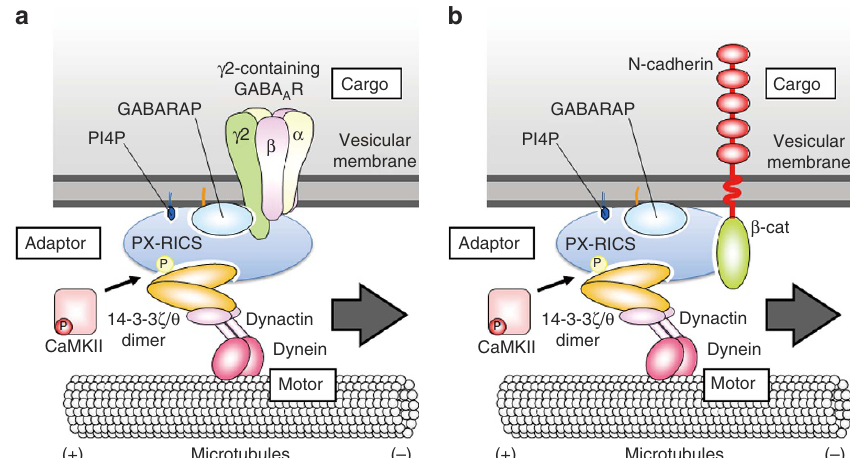
Figure 6 | A possible model for a PX-RICS-dependent cargo-motor interconnection. ( a ) The multiple domains mediating protein–protein and protein–phospholipid interactions of PX-RICS enables PX-RICS to play a central role as a scaffold in assembling the constituents of the trafficking complex. Cargo recognition is conducted by GABARAP through its binding to the cytoplasmic region of the g 2 subunit 31 . GABARAP also serves as a binding cue